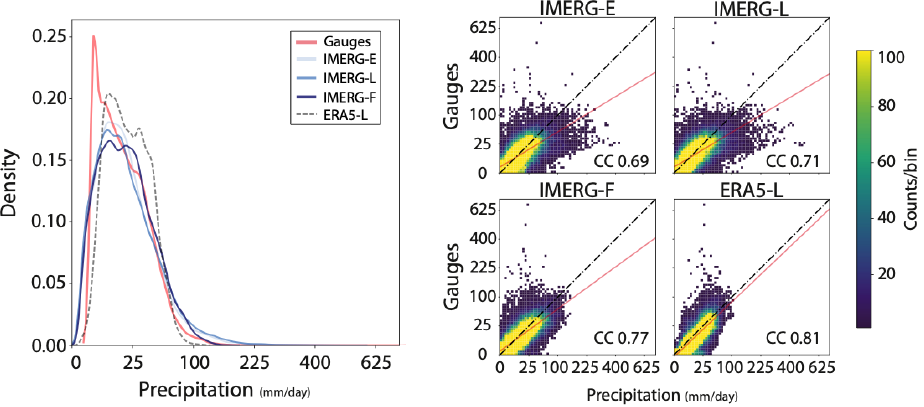
Figure 5. (Left) Density plot of 24-h accumulated precipitation for gauges, IMERG-E, IMERG-L, Figure 5. ( Left ) Density plot of 24-h accumulated precipitation for gauges, IMERG-E, IMERG-L, IMERG-F, and ERA5. (Right) Scatter plots comparing precipitation for 55 cases at every grid point. IMERG-F, and ERA5. ( Right ) Scatter plots comparing precipitation for 55 cases at every grid